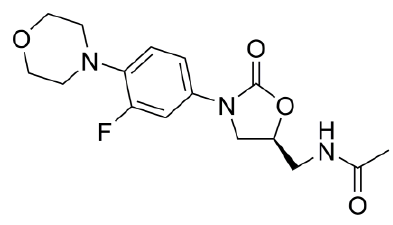
Figure 3. Chemical structure of linezolid.